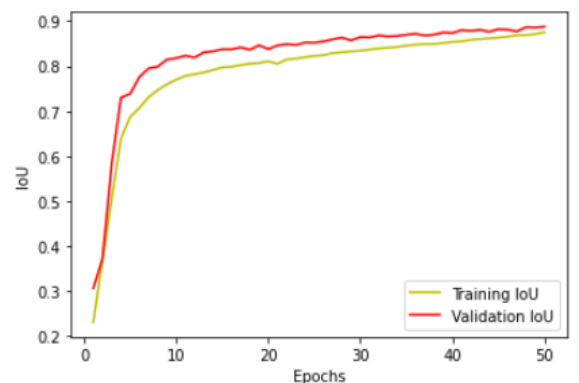
Figure 5 . Training and validation learning curves of IoU.